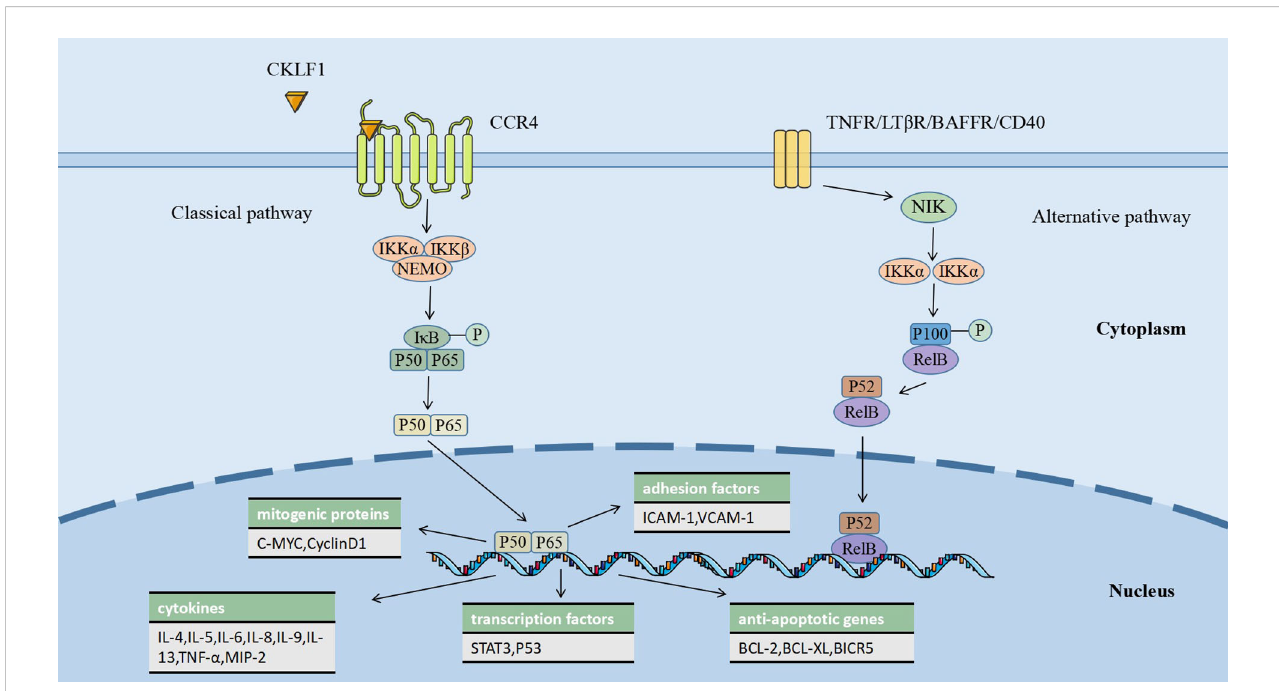
FIGURE 1 CKLF1 binds to CCR4 and activates the NF- k B classical pathway, causing a variety of biological processes, including the release of in fl ammatory factors in the nucleus, the transcription of anti-apoptotic genes, and the expression of mitogenic proteins, which are involved in the regulation of immune- in fl ammatory